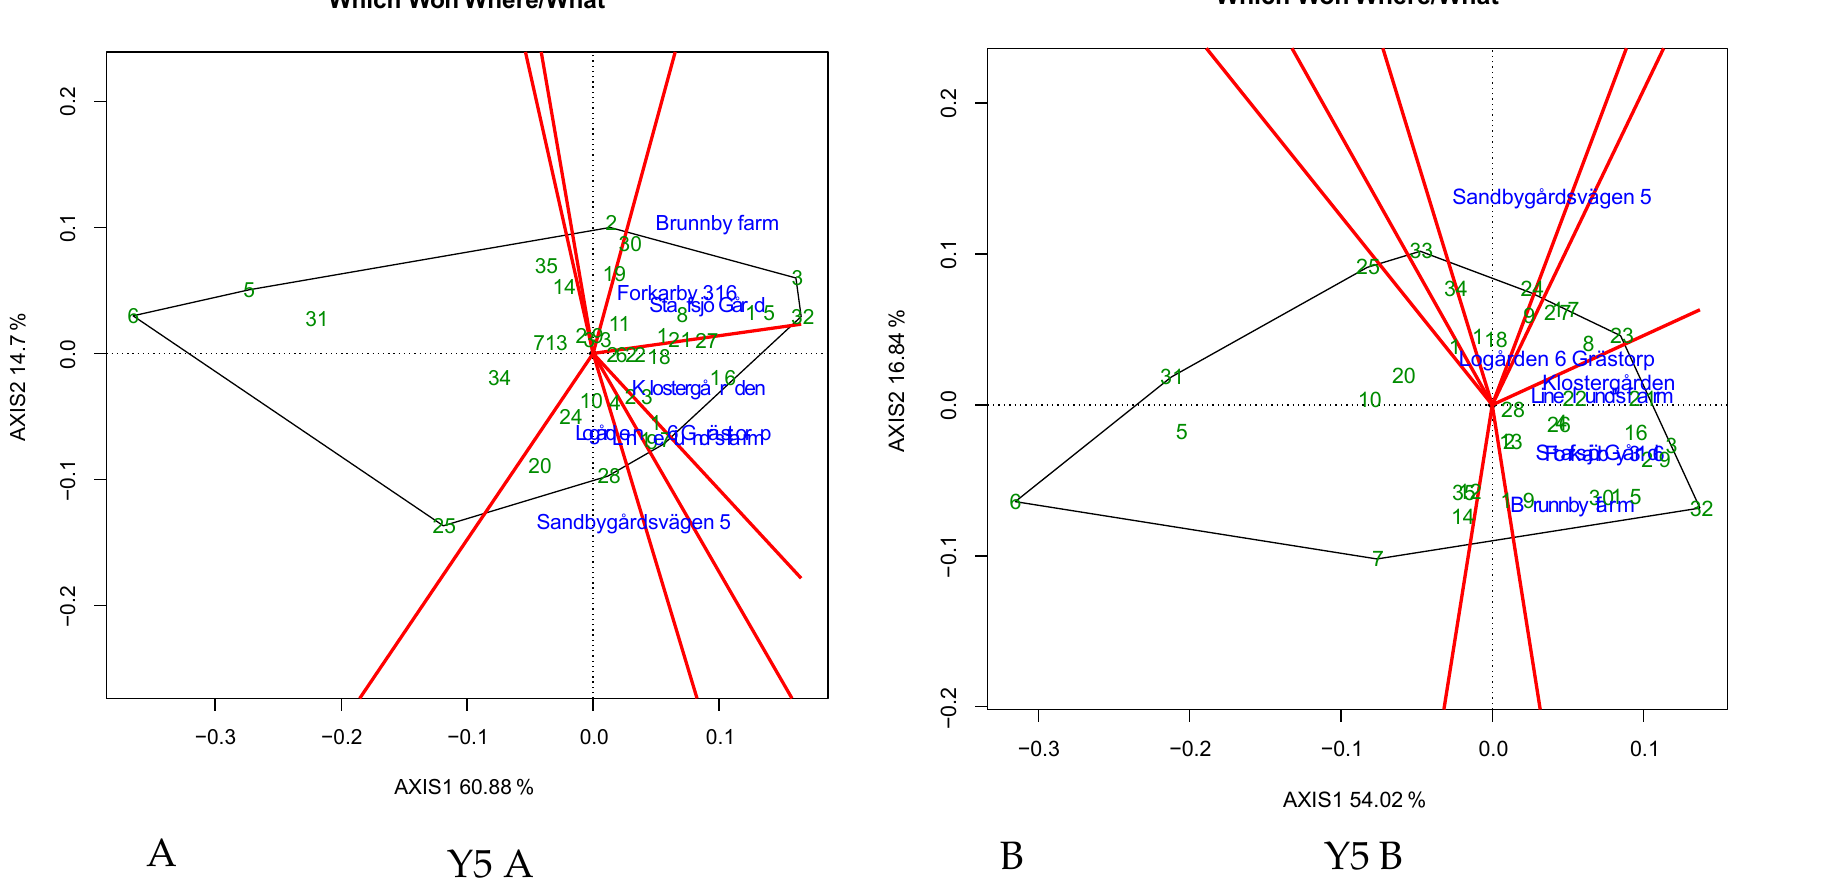
Figure 6. Which-won-where (WWW) plots of barley genotypes and environments under evaluation, indicating mega environments (MEs) and winning genotypes under untreated ( A ) and treated ( B ) conditions, across five years (Y1 to Y5).